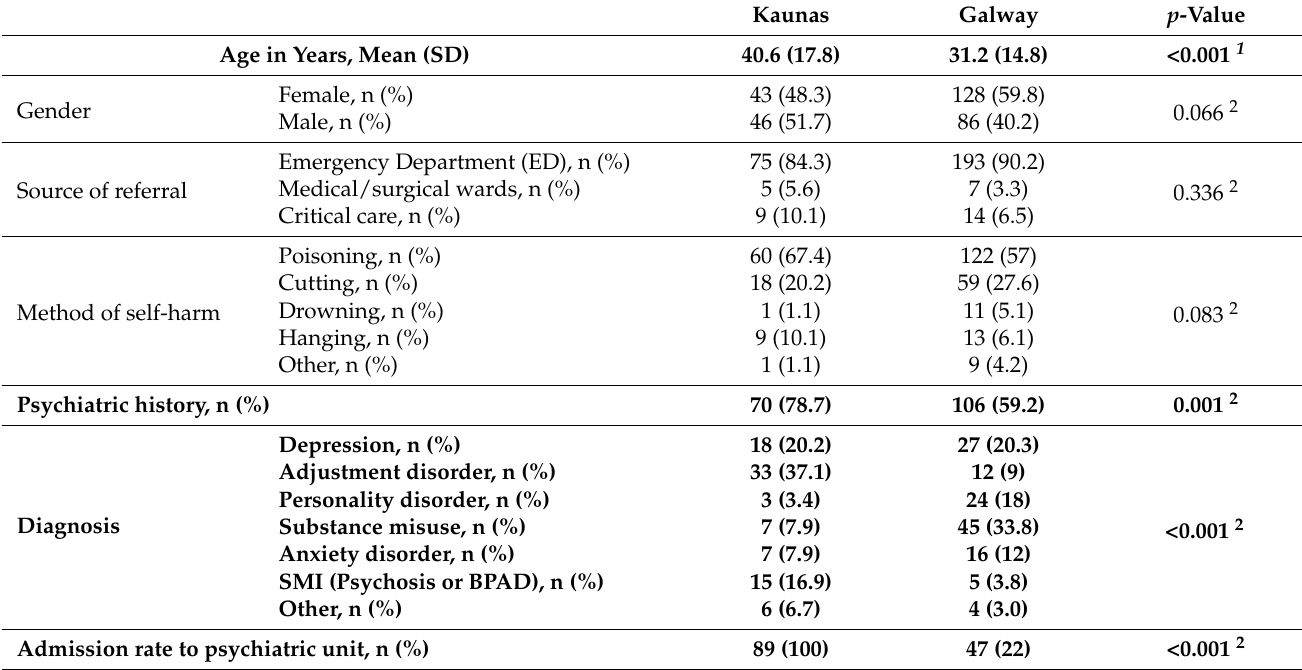
Table 1. Basic demographic & clinical details of patients presenting with self-harm at the two sites.